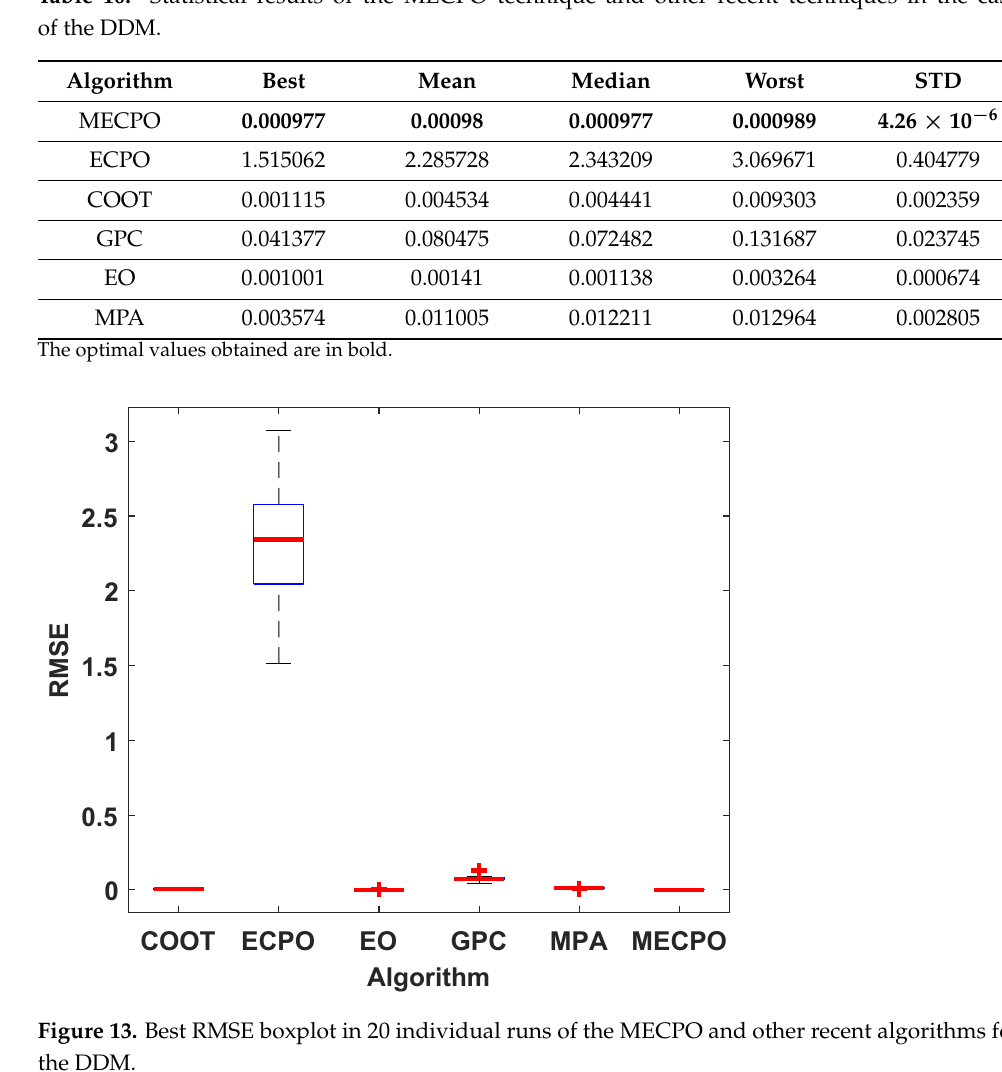
Table 11. Experimental and simulated data of voltages, currents, and power and the absolute errors values using MECPO for DDM.